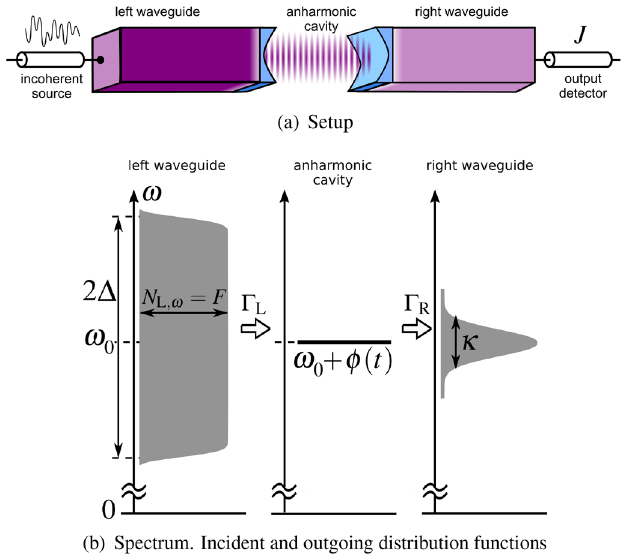
Figure 1. ( a ) Sketch of the setup. The incoherent drive source emits photons into the left waveguide. The difference in filling color transparencies stands for a difference in light intensities. The standing wave between blue mirrors is the cavity mode. The current J is measured in the output detector. ( b ) The spectrum of the incident and outgoing photon states. Incident photons have flat spectrum N L, ω color), nonequilibrium outgoing distribution function have Gaussian shape of width κ . Fluctuating potential φ( t ) is induced by the Bose-Hubbard